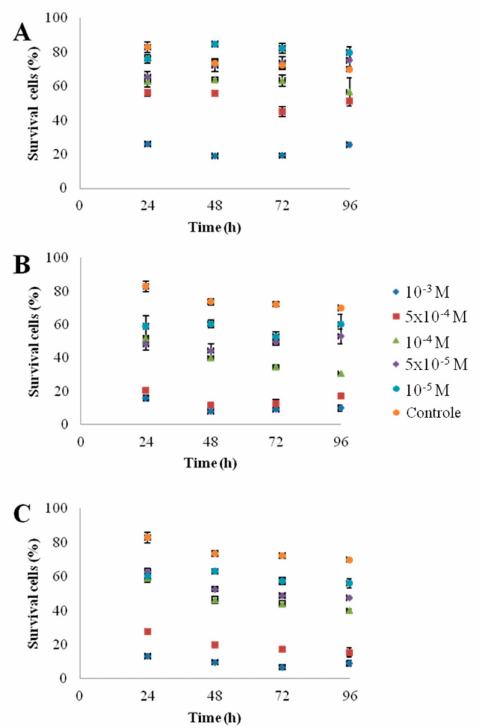
Figure 5. Chlorella vulgaris viability as a function of time after contact with nanoparticles in Seine river water: ( A ) ZnO, ( B ) CdS-1, ( C )